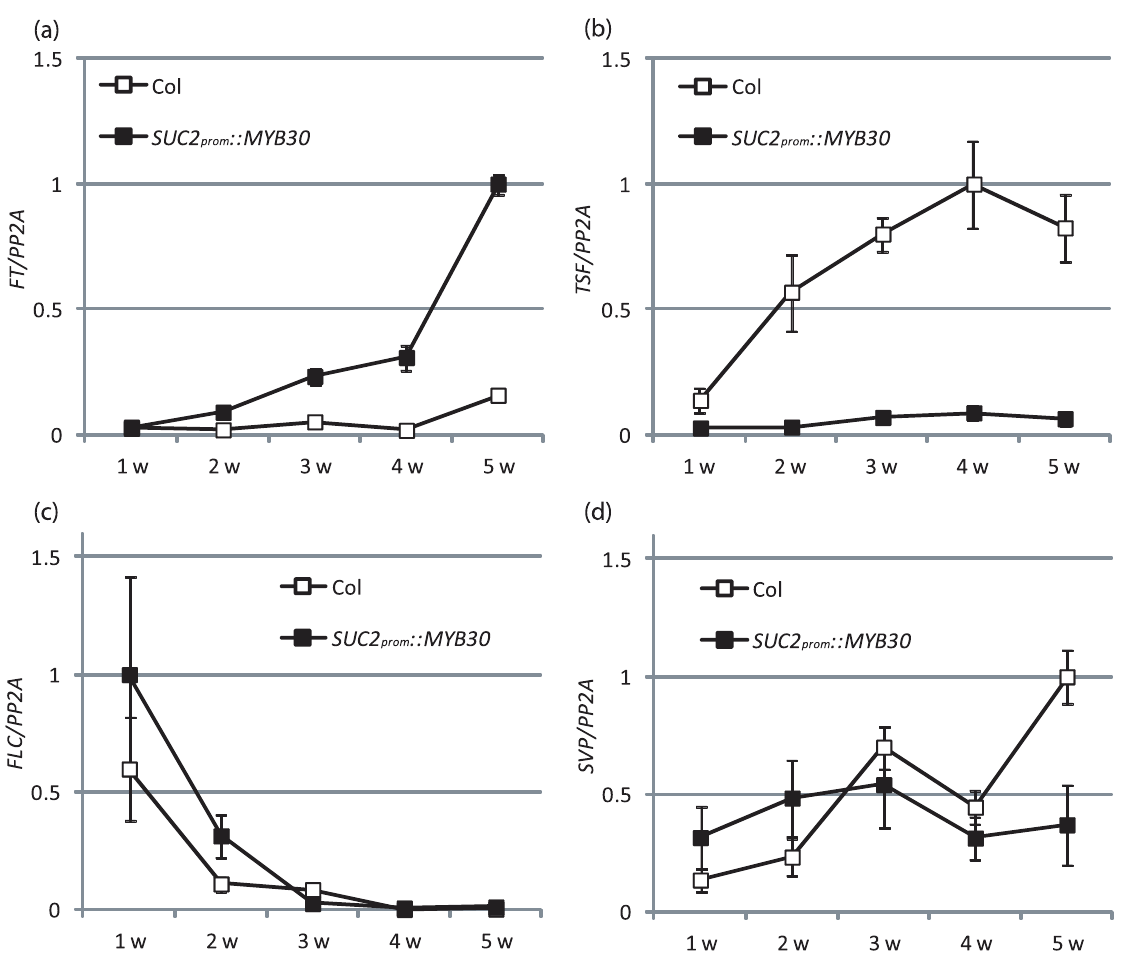
Figure 3. Expression of flowering time genes in SUC2 prom ::MYB30 expressing plants during development. Material was collected once per week at ZT16 from WT and SUC2 prom ::MYB30 expressing Col plants grown in LDs in climate chamber. Samples of 1 week and 2 week old plants were collected from all aerial parts, those of 3–5 weeks from leaves. Expression levels were measured by RT-qPCR for FT ( a ), TSF ( b ), FLC ( c ), and SVP ( d ). Values are shown as Mean 6 SD after normalization of expression with values obtained for PP2A for technical triplicates. A biological replicate of the experiment gave similar results.